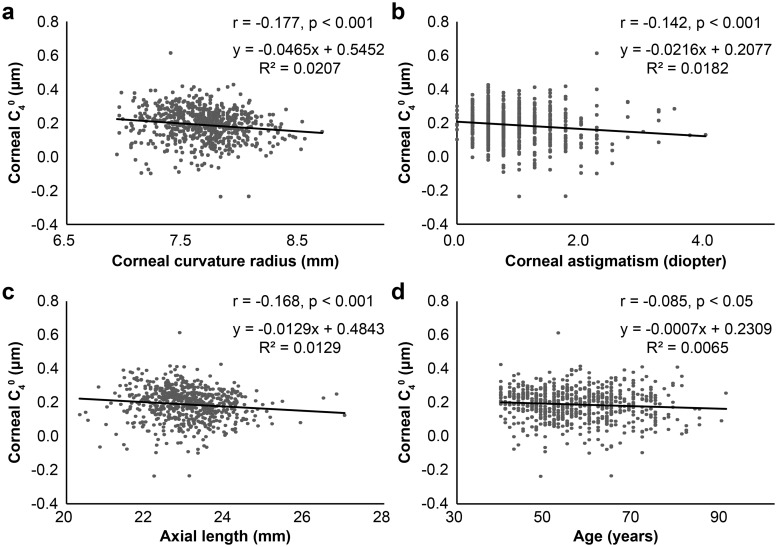
Relationships between corneal spherical aberration (C40) and ocular parameters, and age.(a) Scatterplots demonstrating corneal curvature radius and C40. A significant correlation was observed between the two (Spearman’s correlation coefficient, r = -0.177, p < 0.001). (b) Scatterplots demonstrating corneal astigmatism and C40. A significant correlation was observed between the two (r = -0.142, p < 0.001). (c) Scatterplots demonstrating axial length and C40. A significant correlation was observed between the two (r = -0.168, p < 0.001) (d) Scatterplots demonstrating age and C40. A significant correlation was observed between the two (r = -0.085, p < 0.05).